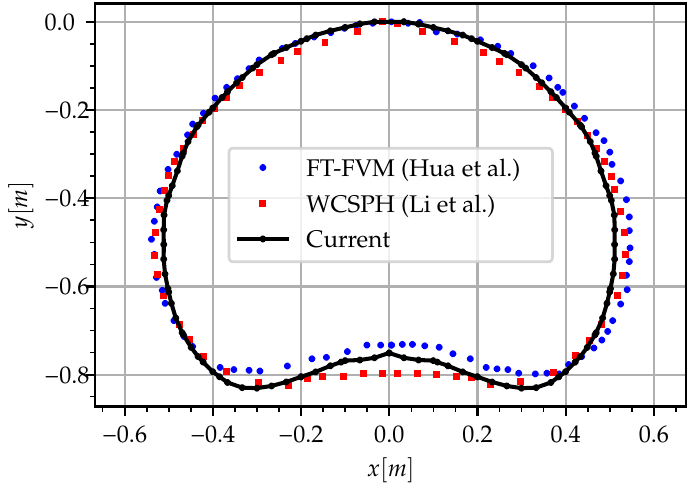
Figure 9. Terminal bubble shape compared against [3] and [49].